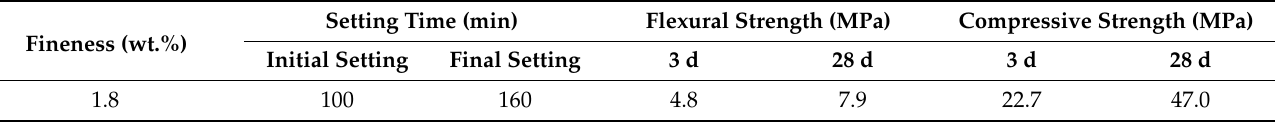
Table 2. Physical properties of ordinary Portland cement.